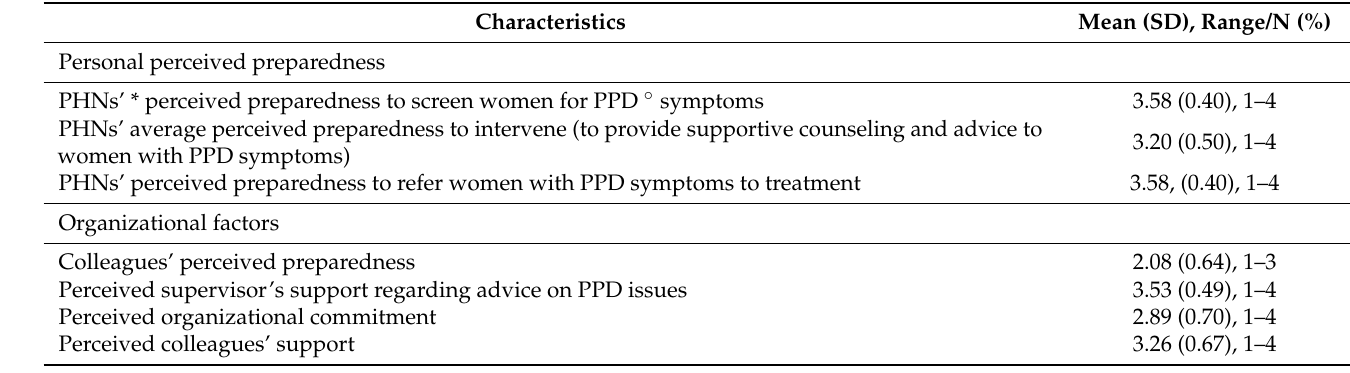
Table 2. Nurses’ personal perceived preparedness to screen, intervene and refer in cases of suspected postpartum depression, and organizational factors (N = 219).